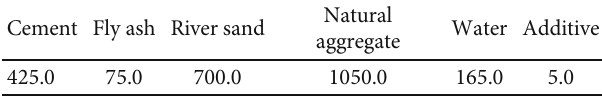
Table 5: Mix proportion of reference concrete (kg/m 3 ).